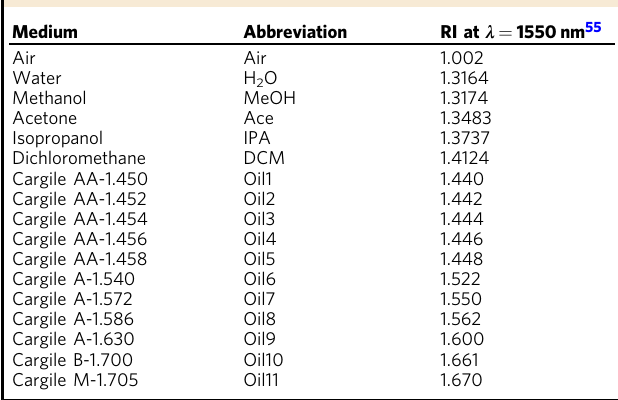
Table 1 Refractive index (RI) of liquids applied inside of nanohole